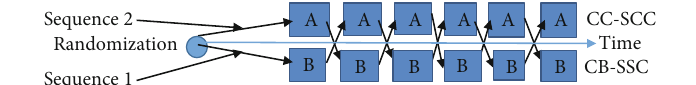
Figure 1: Participant fl ow.